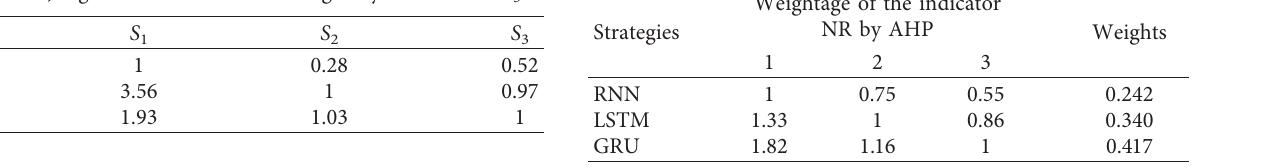
Table 7: Judgment matrix of the strategic layer relative to I